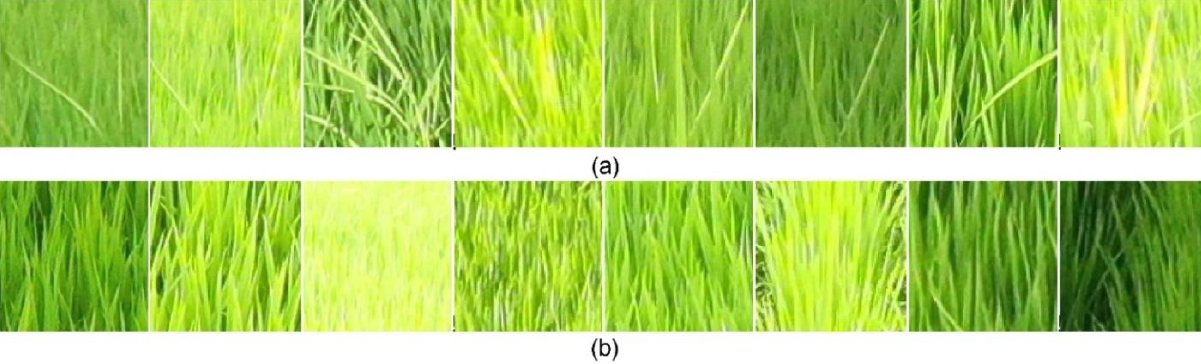
Figure 7. An example of image cropping RBD and normal rice plants: ( a ) Images in which the area containing rice infected with Bakanae disease is cropped, and ( b ) images in which an area containing normal rice is cropped.